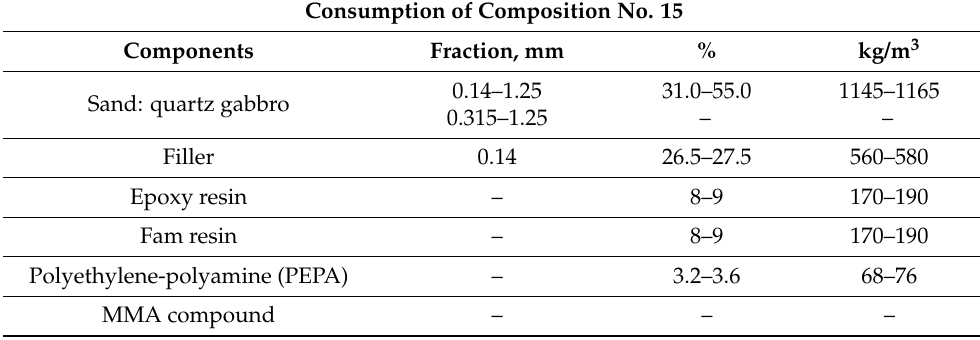
Table 1. Polymer-concrete composition No. 15.